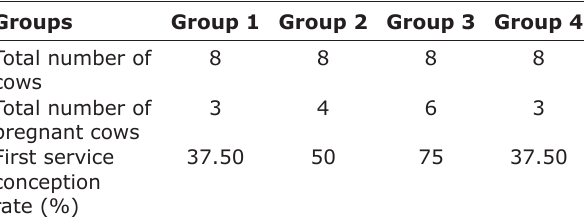
Table-3: Conception